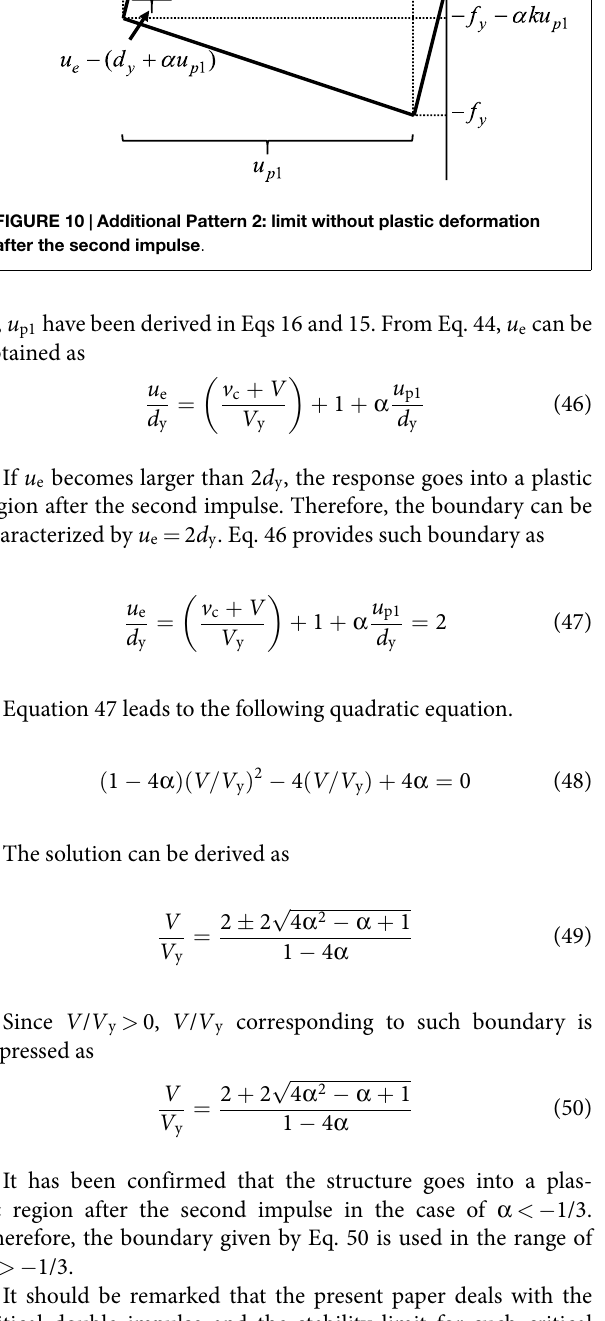
v c , u p1 have been derived in Eqs 16 and 15. From Eq. 44, u e can